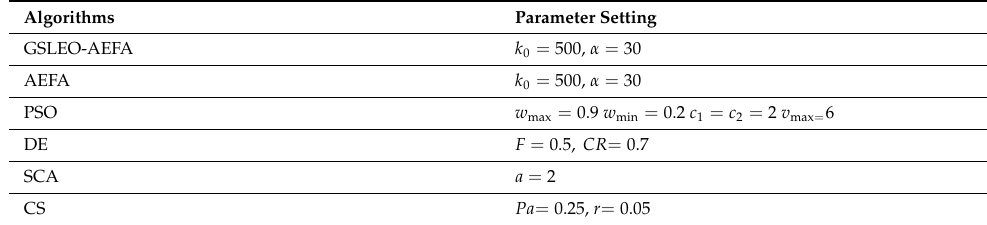
Table 1. Parameter Settings.